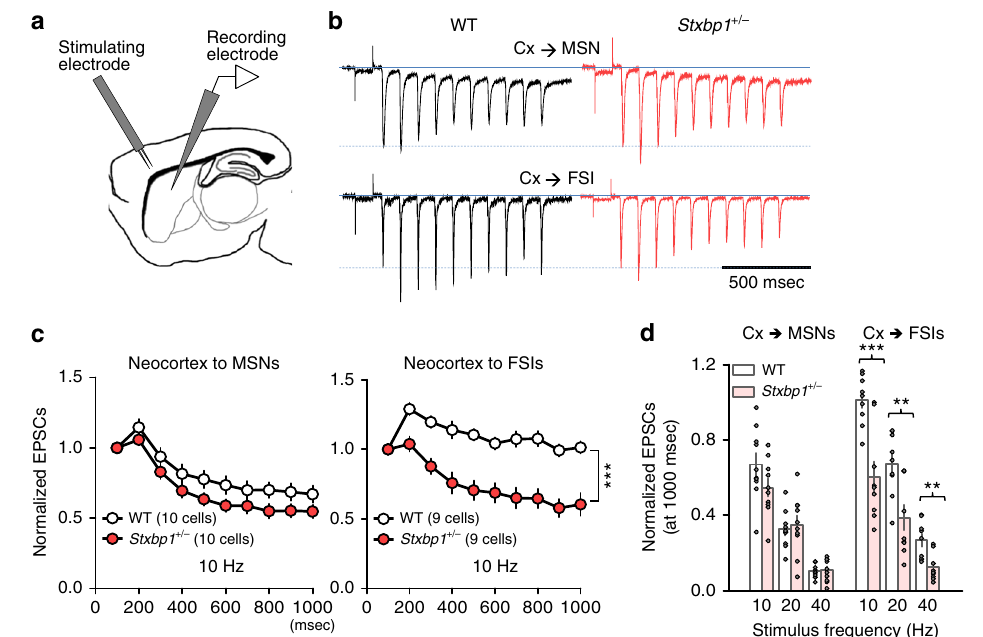
Fig. 5 Impaired cortico-striatal FSI excitatory transmission in Stxbp1 + / − mice. a Whole-cell recording con fi guration. b Representative traces of EPSCs in striatal MSNs and FSIs evoked by SSC electrical stimulations at 10 Hz. The initial EPSC responses are scaled to the dotted lines. c EPSCs showed faster rundown in FSIs (right), but not in MSNs (left), of Stxbp1 + / − mice, compared to WT mice. 10 Hz stimulation [after 1000 ms stimulation, unpaired t test, WT (9 cells) vs. Stxbp1 + / − (9 cells), FSI, t 16 = 4.46, *** P = 0.0004]. d Steady-state levels of evoked EPSCs 1,000 ms after repetitive cortical stimulation ranging from 10 to 40 Hz. 10 MSNs and 9 FSIs, 19 slices from 9 WT mice; 10 MSNs and 9 FSIs, 19 slices from 9 Stxbp1 + / − mice. Unpaired t test, WT vs. Stxbp1 + / − , MSN, 10 Hz: t 18 = 1.61, P = 0.128; 20 Hz: t 18 = 0.4163, P = 0.6821; 40 Hz: t 18 = 0.3123, P = 0.7584. FSI, 10 Hz: t 16 = 4.46, *** P = 0.0004; 20 Hz: t 16 = 3.277, ** P = 0.0047; 40 Hz: t 16 = 3.451, ** P = 0.0033. Mean± SEM. * P < 0.05, ** P < 0.01, *** P <